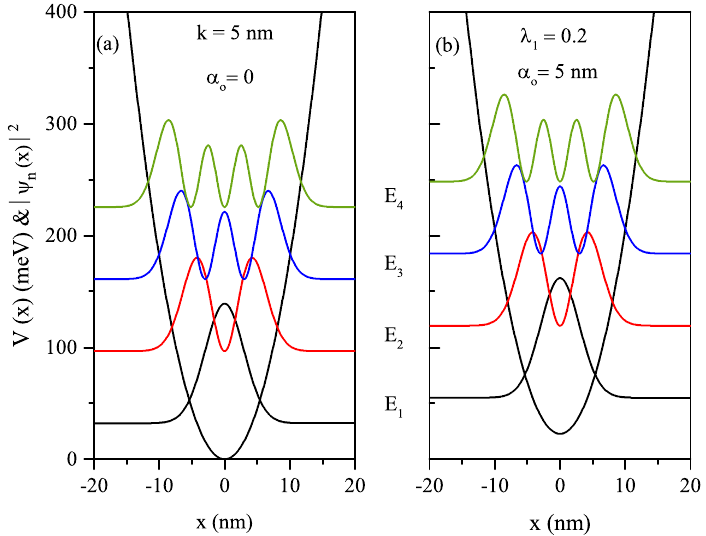
Figure 1. In the absence and presence of the ILF, the HO potential and the squared wave functions of the first four energy levels in relevant energy values in the values of k = 5 nm and λ 1 = 0.2 as a function of x -growth direction coordinate: α 0 = 0 ( a ) and α 0 = 5 nm ( b ), respectively.